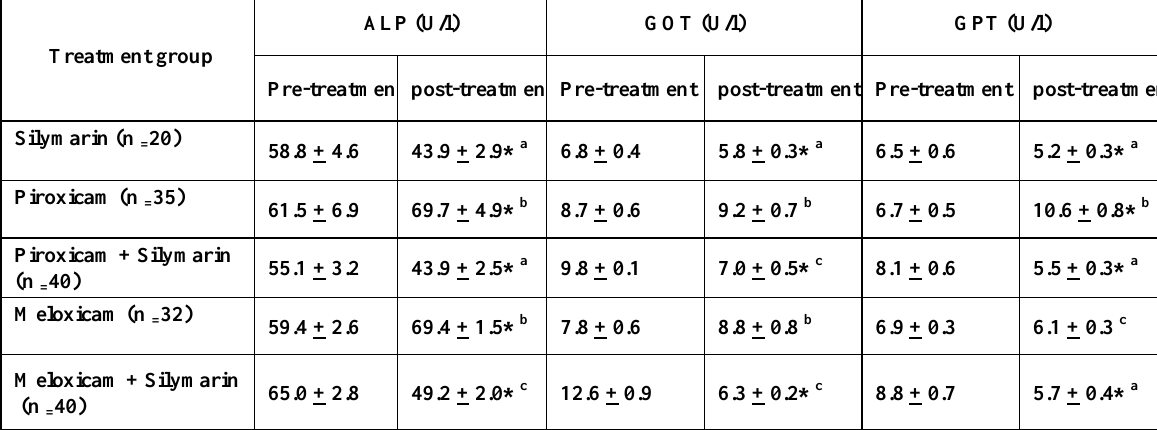
Table 2. Effects of silymarin on the serum levels of the activities of the liver enzymes, Alkaline phosphatase (ALP), Glutamate-oxaloacetate aminotransferase (GOT) and Glutamate-pyruvate aminotransferase in OA patients treated with piroxicam or meloxicam. Treatment